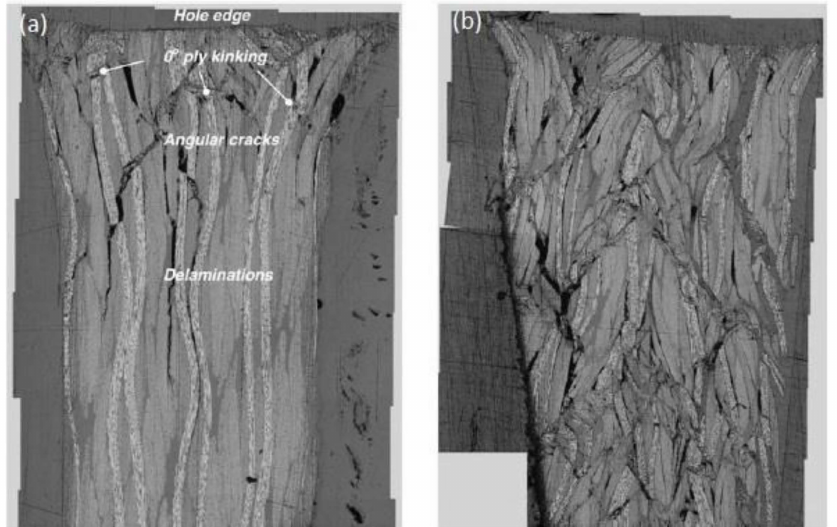
Figure 21. Section view of the laminate without pins: ( a ) immediately after initial bearing failure and ( b ) after loading well beyond the maximum bearing load